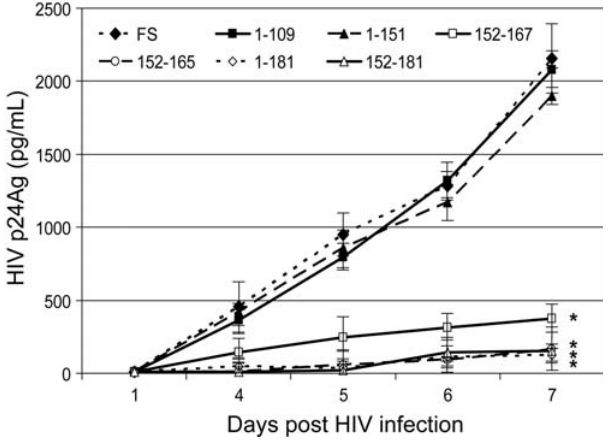
Figure 2. HIV growth characteristics in selected Jurkat cell lines expressing the GBV-C NS5A sequences. HIV replication in selected cell lines expressing various GBV-C NS5A peptides summarized in Fig. 1 was assessed by monitoring HIV p24 antigen release into culture supernatants. FS=the 126–237 frame-shift construct (see methods). Numbers refer to the NS5A amino acid sequence expressed in each cell line. *=HIV replication curves significantly less HIV p24 antigen than the frame shift control. (P , 0.01 for the three cell lines that included amino acids 152–165 on days 3, 4, 5).